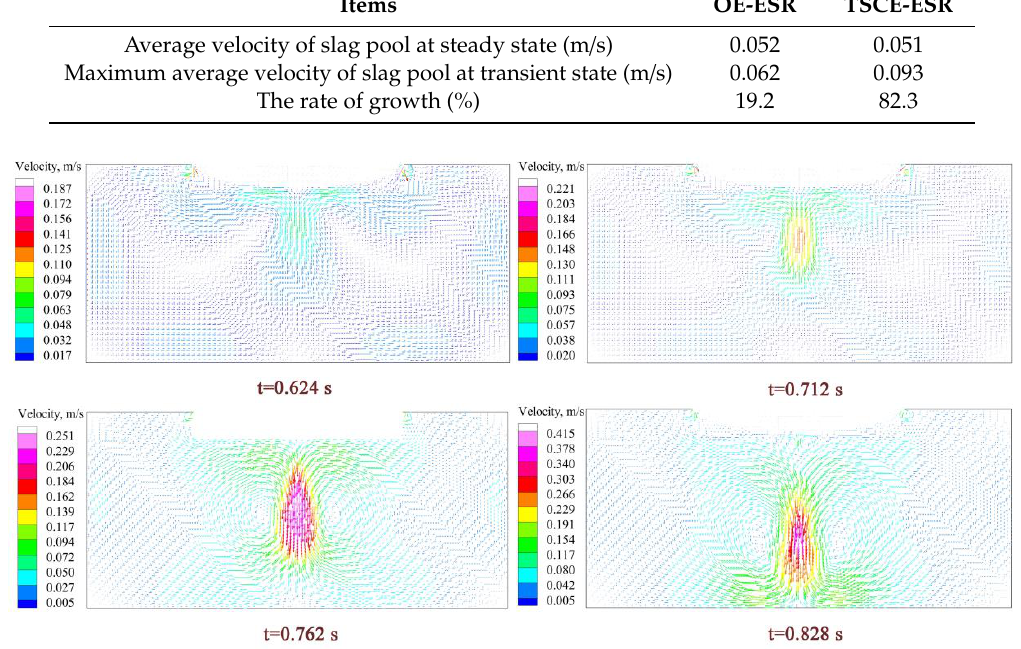
Figure 13. Distribution of velocity field during droplet dripping process of OE-ESR.